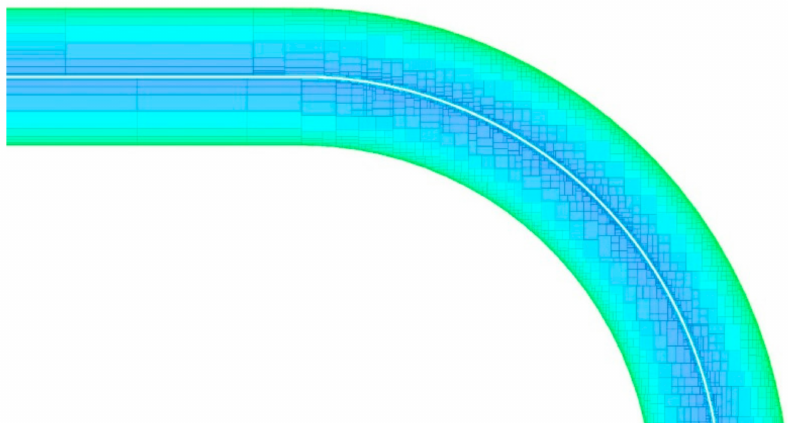
Figure 10. Layout of a waveguide turn with proximity effect correction. Relative dose values are marked with colors—dark blue is lowest dose; green is the